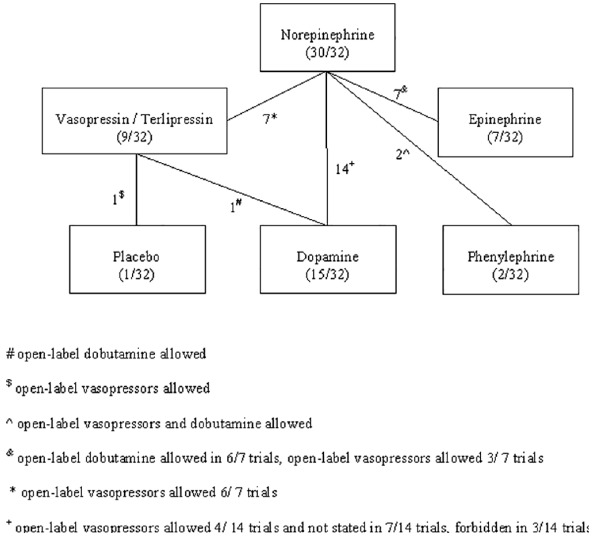
Fig 2. Vasopressors arms